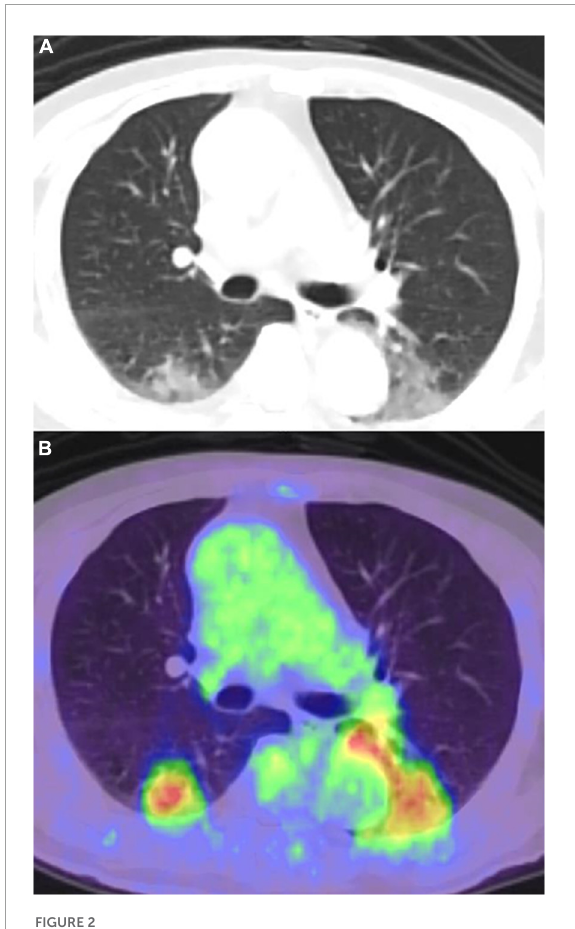
FIGURE2 Pneumonia caused by bronchoscopy performed a day before the FDG-PET/CT, misidentified as COVID-19 pneumonia. (A) CT image, (B) PET/CT